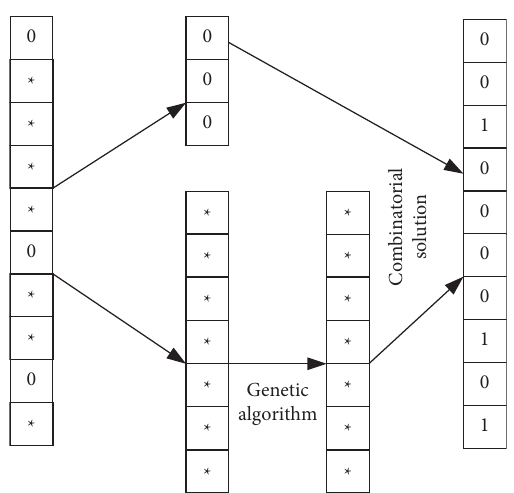
Figure 2: Combined encoding